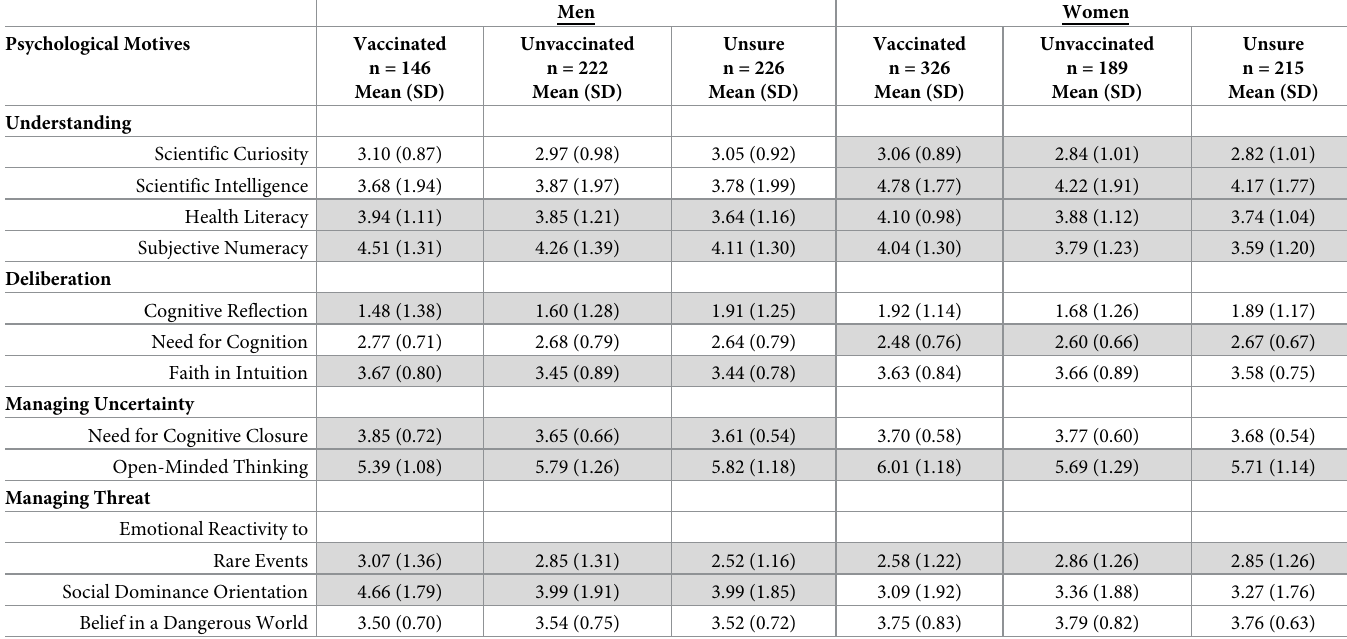
Table 7. Psychological trait differences based on vaccination status and